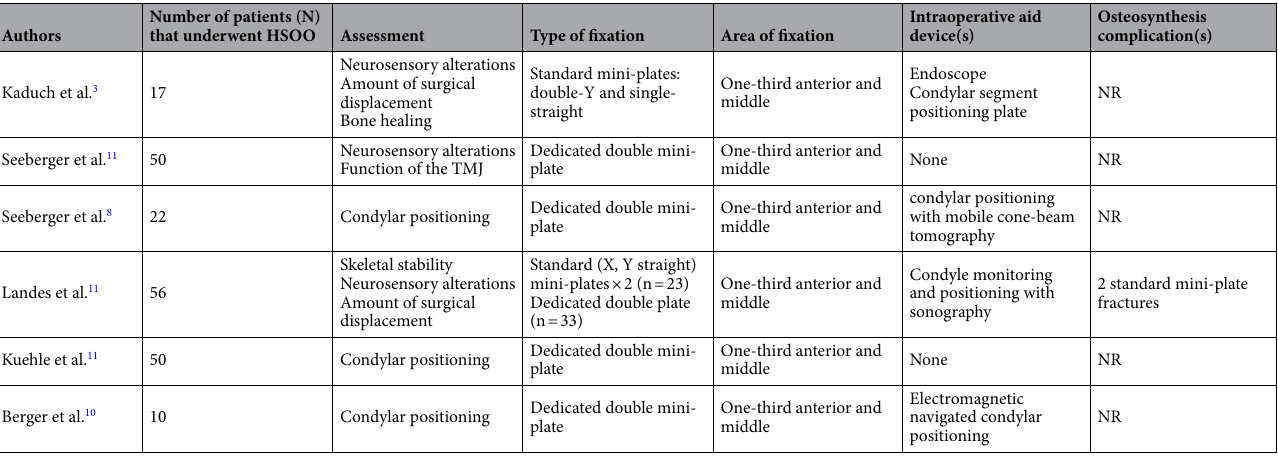
Table 2. Main HSOO clinical studies. NR, not reported; TMJ, temporo-mandibular joint.